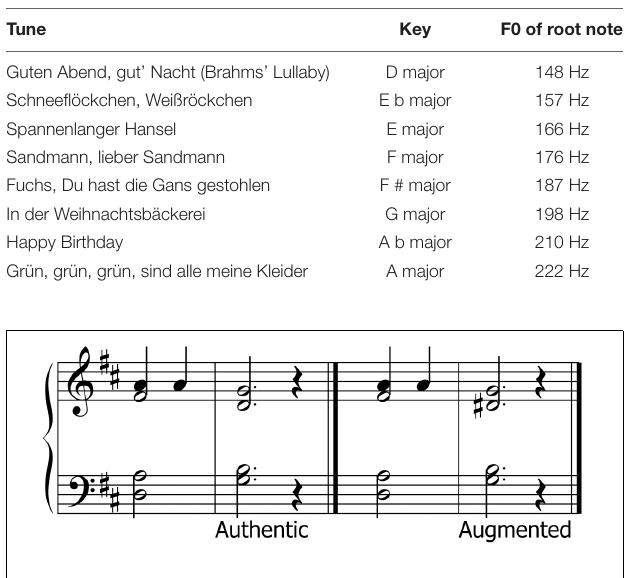
FIGURE 5 | Exemplary score of the two final bars of a song harmonization, containing an authentic V-I cadence and a cadence ending with an augmented chord (right).